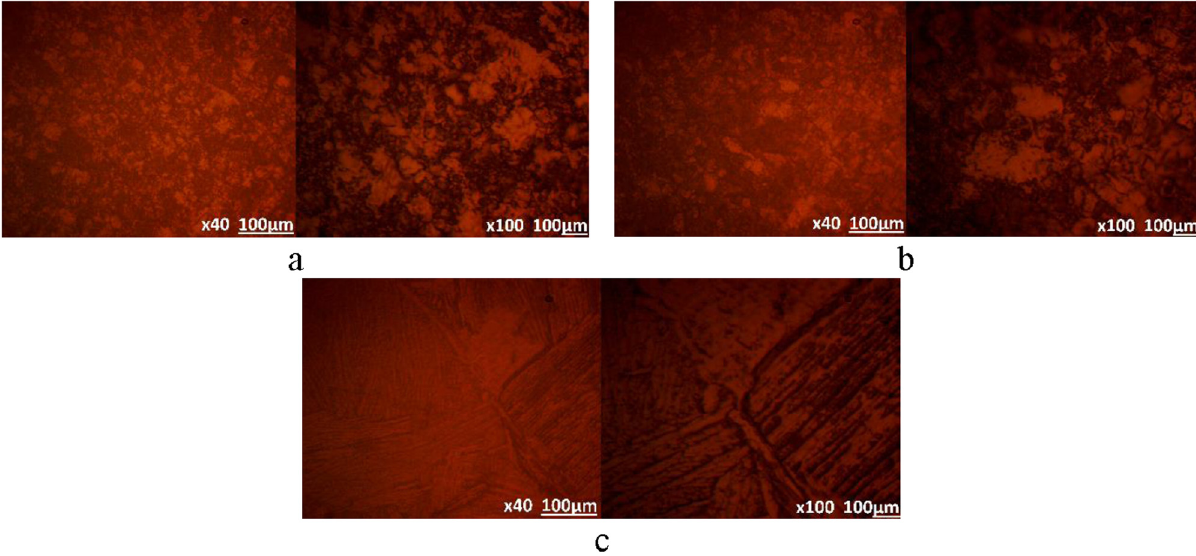
Figure 10: Optical images of ( a ) B265TiN, ( b ) B265TiQ, and ( c ) B265TiA after corrosion test in 2 M H 2 SO 4 + 10% NaCl at